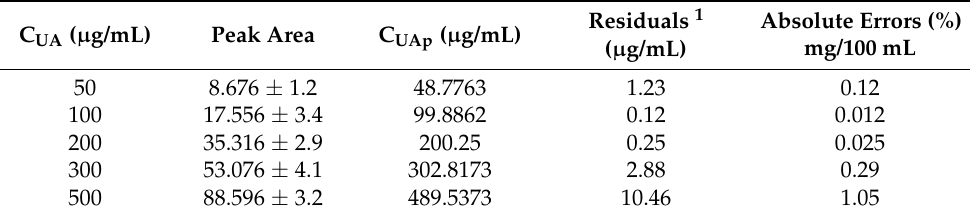
Table 1. Data of the calibration curve: peak area (A mean ± SD), UA standards concentrations (C UA ), UA predicted concentrations (C UAp ), residuals, and absolute percentage